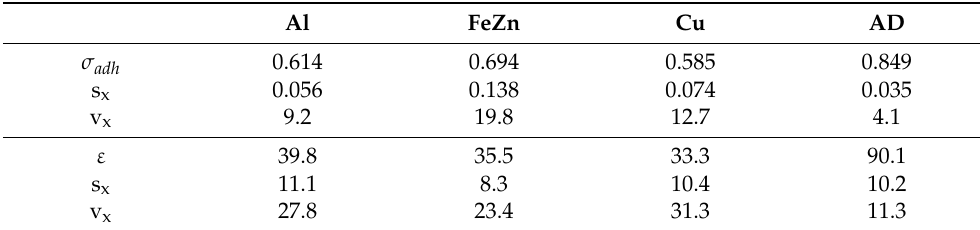
Table 1. Results of tensile adhesion σ adh (in MPa) and elongation ε (in %), standard deviation s x (in MPa for σ adh , in % for ε ) and coefficient of variation v x (in %) 1 for aluminium alloy (Al), galvanised steel (FeZn) and copper alloy (Cu) targets compared to results of adhesive alone (AD) on aluminium targets.